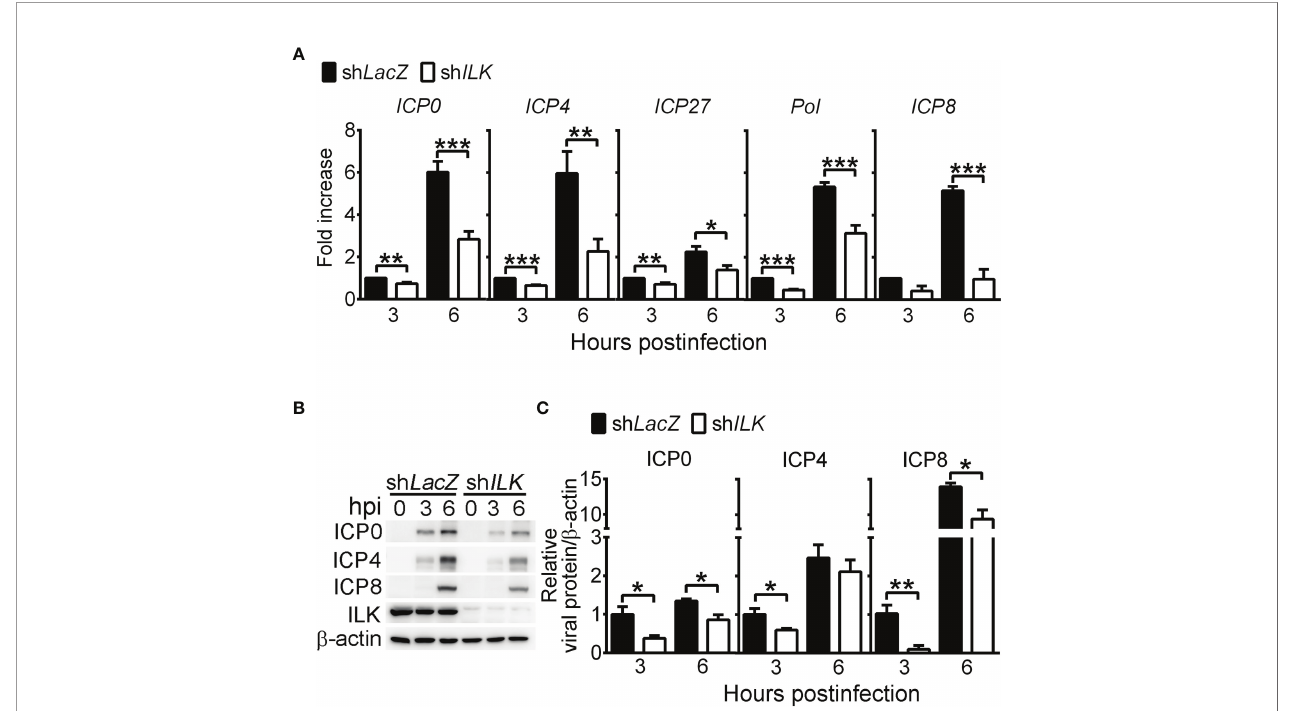
FIGURE 2 | ILK increases HSV-1 IE and E gene expression. (A) The relative transcript levels of viral IE genes ( ICP0 , ICP4 , and ICP27 ) and E genes ( Pol and ICP8 ) in control (sh LacZ ) and ILK knockdown (sh ILK ) cells at indicated hours postinfection (hpi) quanti fi ed by real-time PCR are shown. The transcript levels of indicated genes normalized to ACTB mRNA in control cells at 3 hours postinfection were set as 1. (B, C) The representative western blots (B) and relative levels (C) of indicated proteins in control and ILK knockdown cells infected with HSV-1 at indicated hours postinfection are shown. The levels of indicated viral proteins normalized to b -actin in control cells at 3 hours postinfection were set as 1. Data represent mean + SEM (error bar). * p < 0.05, ** p < 0.01, *** p < 0.001 via Student t